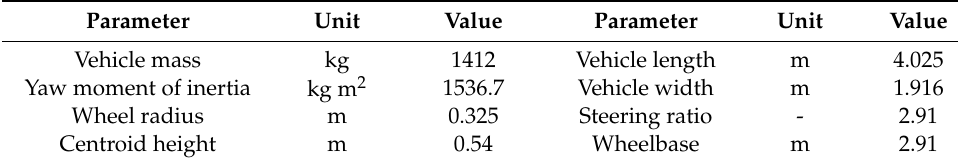
Table 2. CarSim key parameters of simulation vehicle